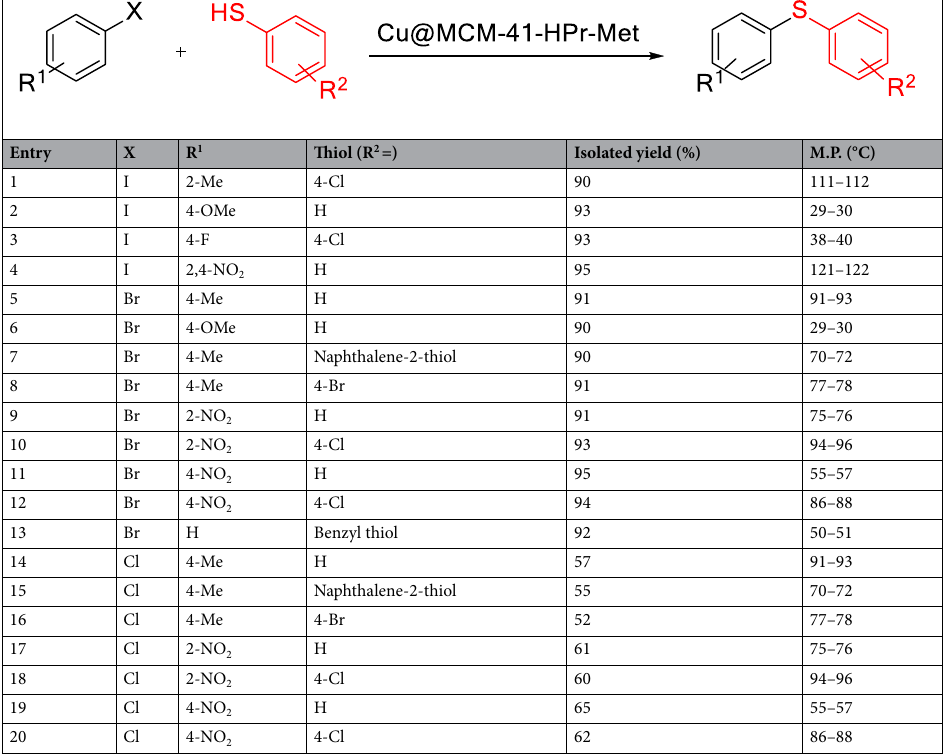
Table 4. Reactions of aryl halides with thiophenols in the presence of Cu@MCM-41-HPr-Met. Catalyst amount in all reported reactions is 30 mg.